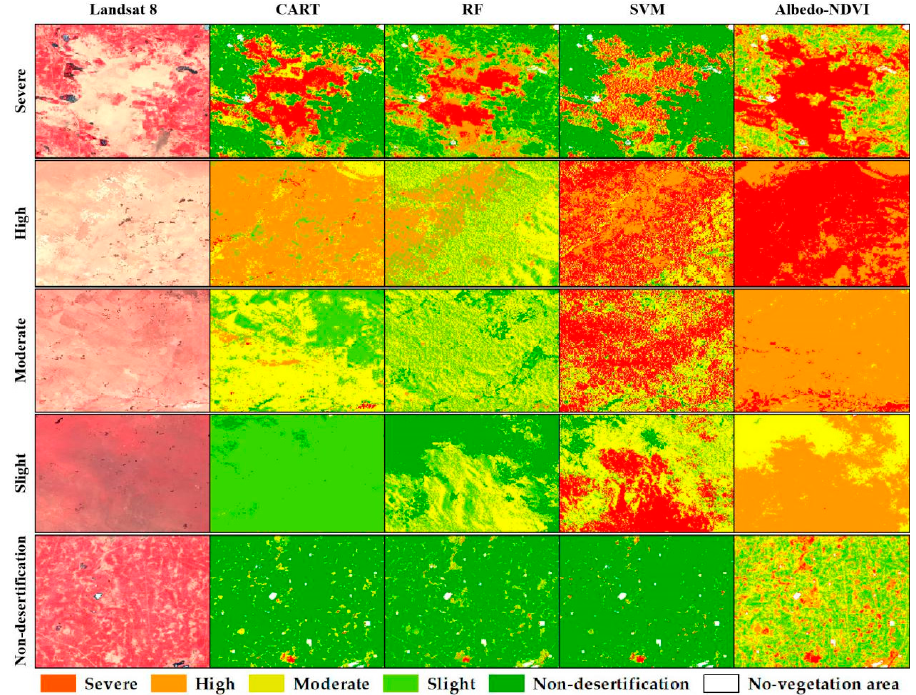
Figure 3. Comparison of different desertification pattern products in 2015. Landsat 8 is false color composition in 2015 (RGB: B5, B4, B3). CART, RF, SVM and Albedo-NDVI are products of four kinds of methods, respectively.